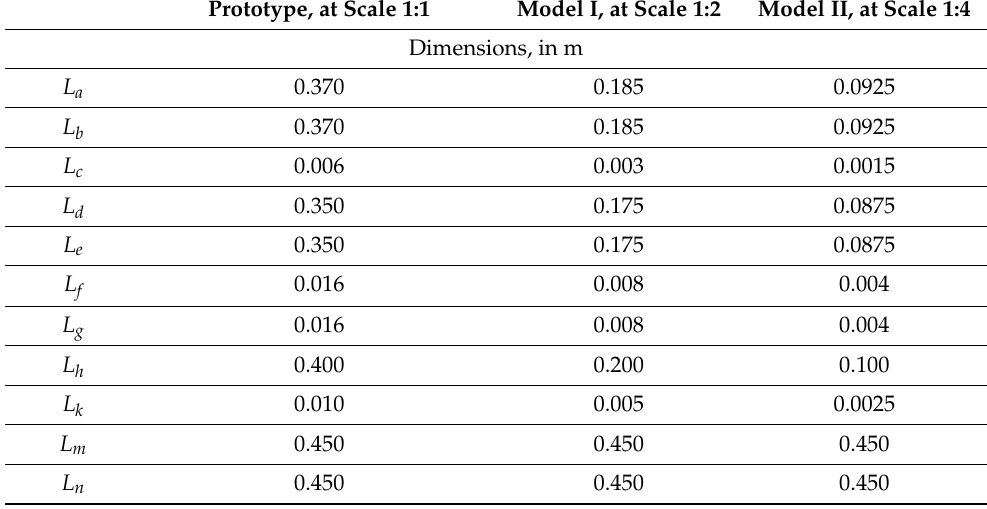
Table 1. Principal dimensions of the column segment presented in Figure 2. Prototype, at Scale 1:1 Model I, at Scale 1:2 Model II, at Scale